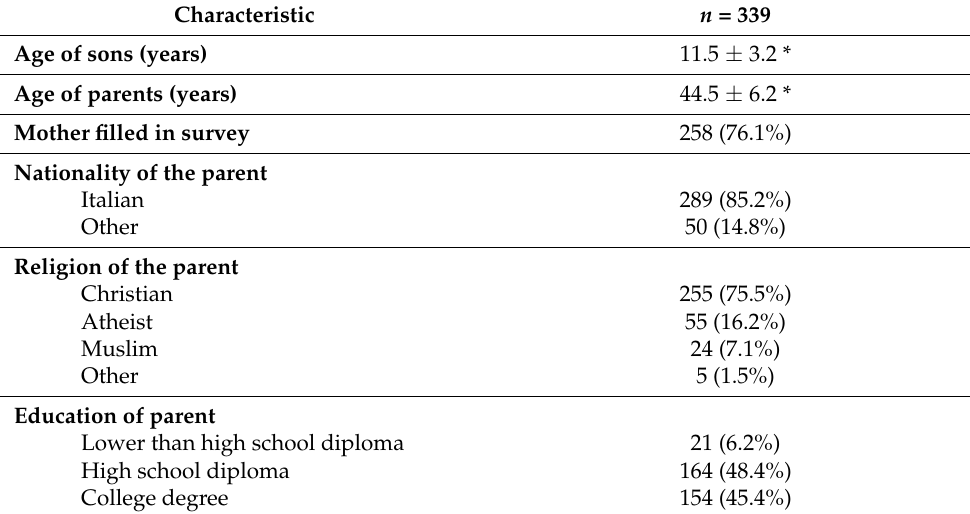
Table 1. Socio-demographic characteristics of the population. Characteristic n =